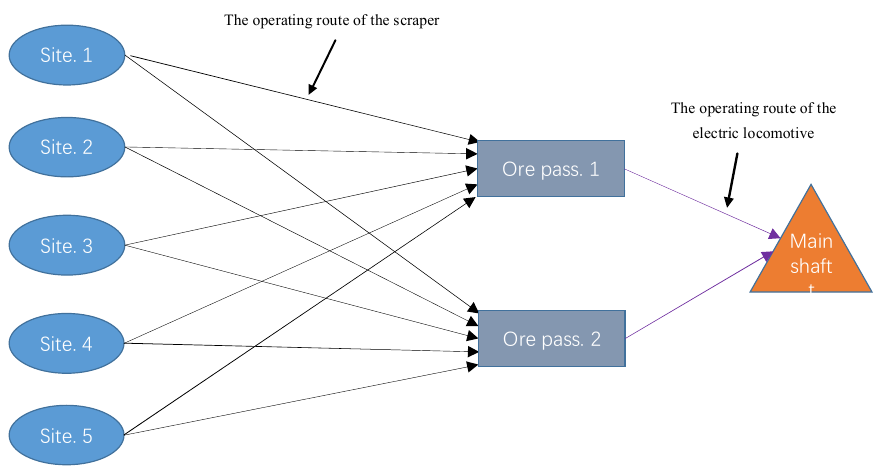
Figure 4. Simple dispatching model.